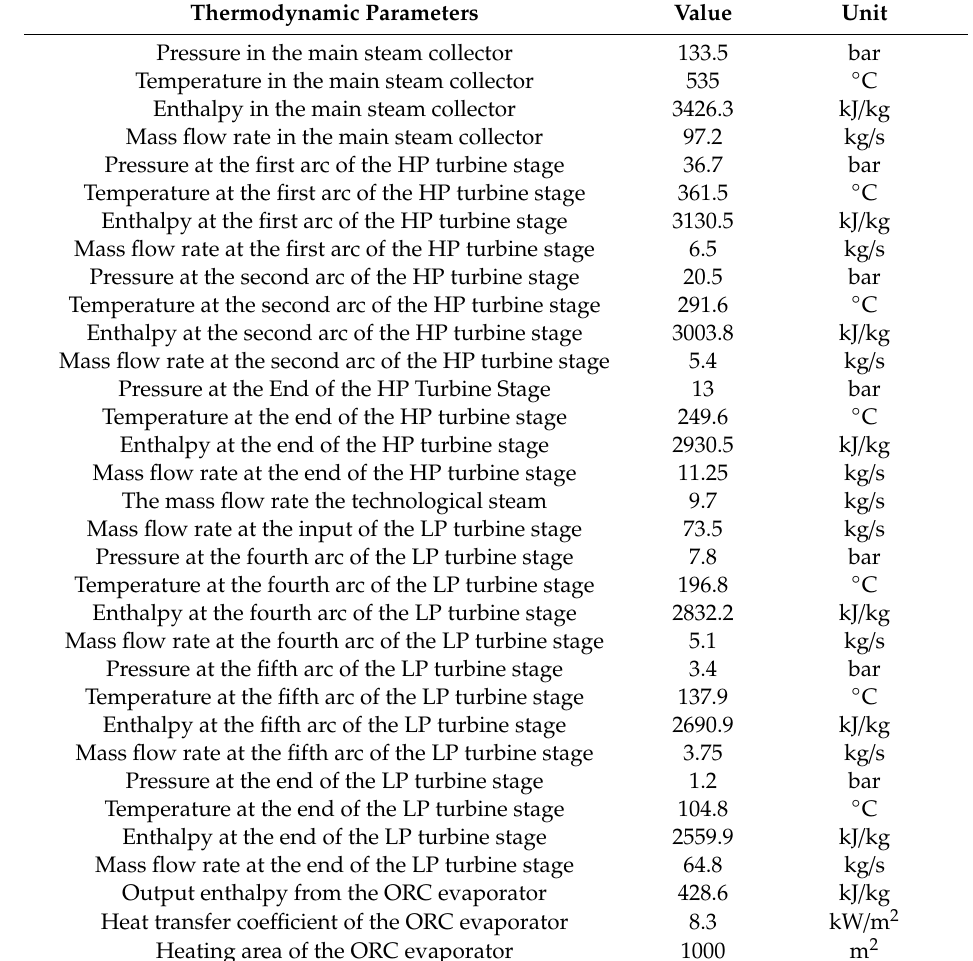
Table 1. Nominal parameters for modeling of the innovative